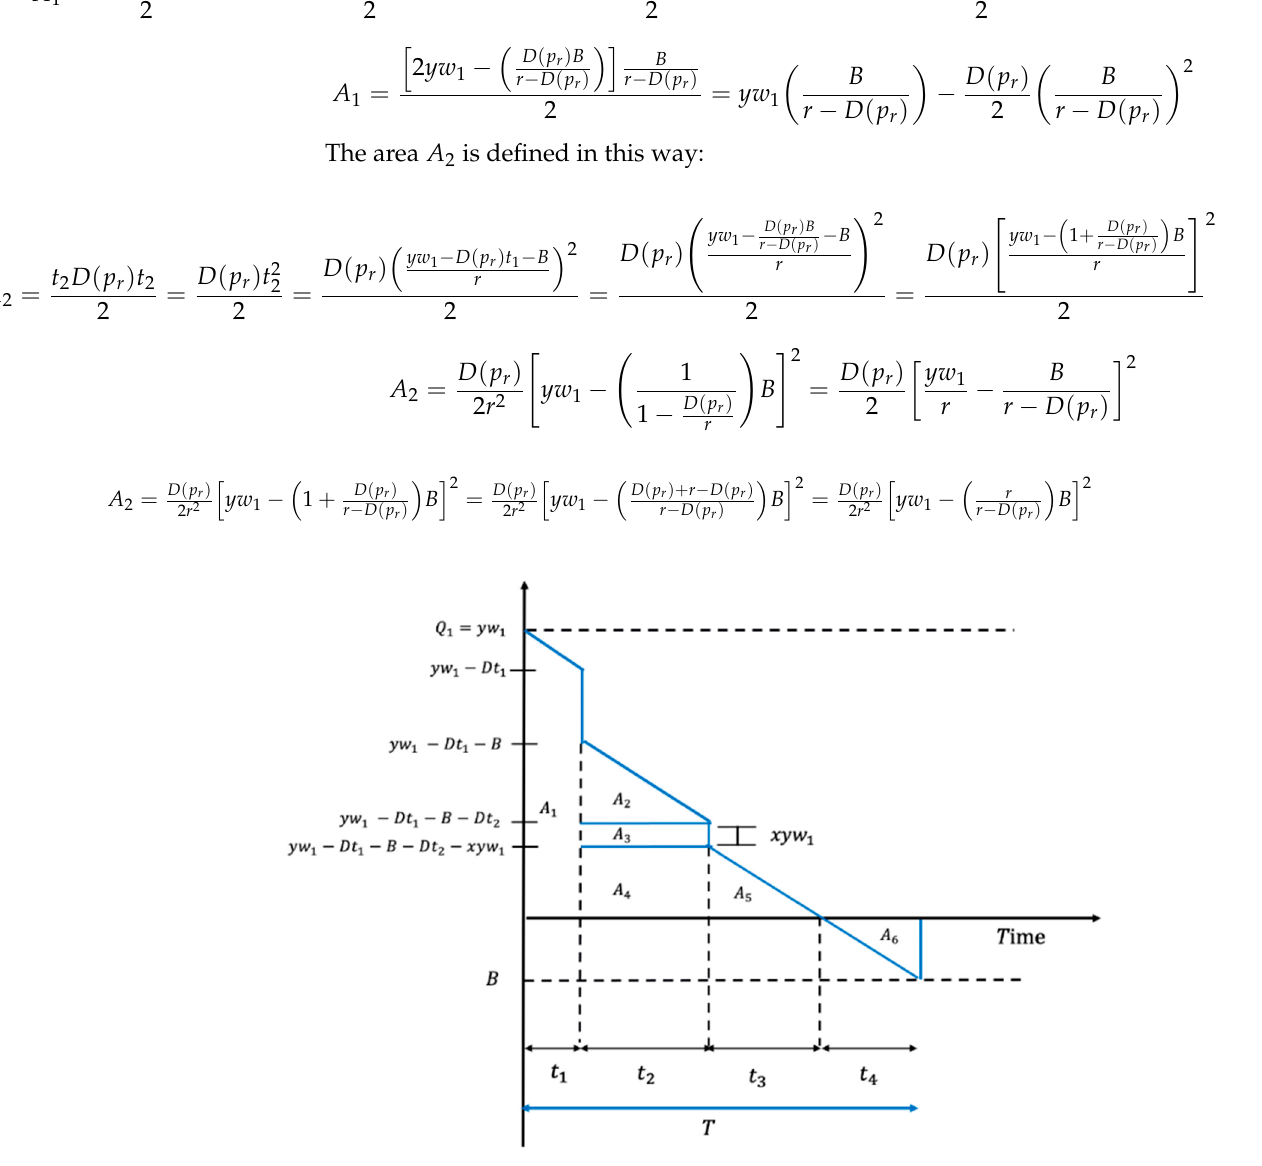
Figure A1. Inventory behavior through time. The area A is obtained as follows: 3